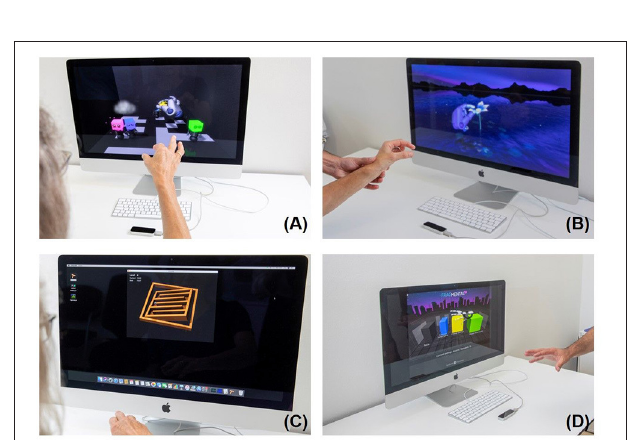
FIGURE 2 | Video based training with GripAble. Top left (A) GripAble device; top middle (B) Plume; top right (C) Windowsill; bottom left (D) patient playing Balloon Buddies; bottom middle (E) Circus Escape; bottom right (F) Pufferfish.